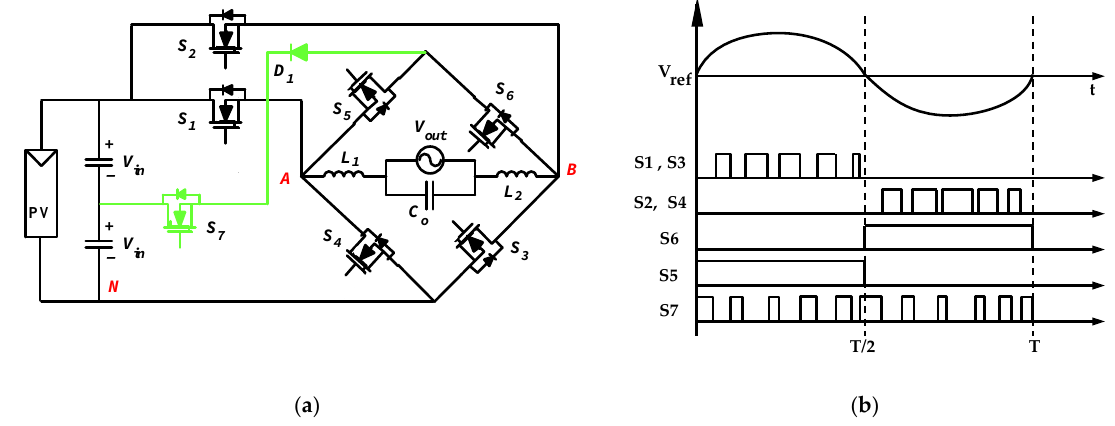
Figure 4. ( a ) The proposed topology, ( b ) Switching pattern.